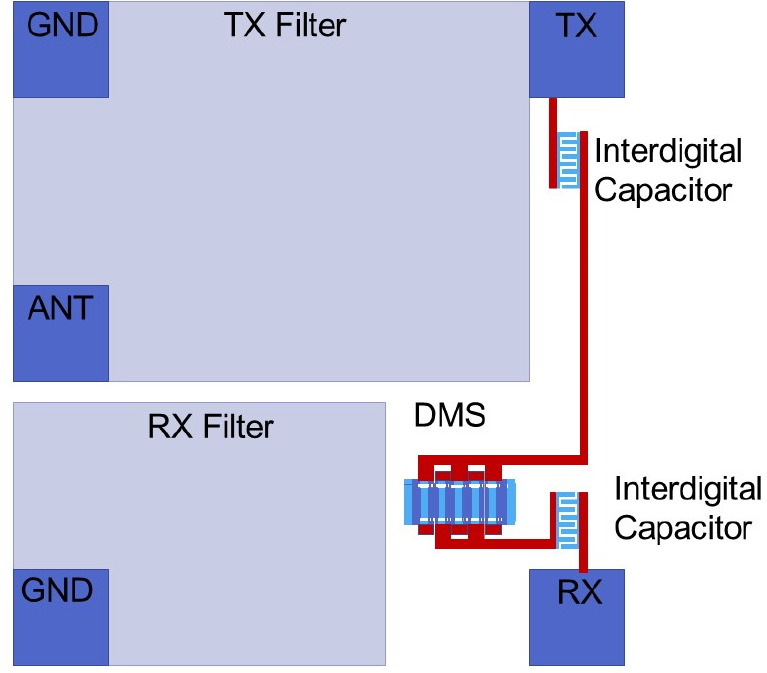
Figure 13. The layout of the phase canceling circuit.